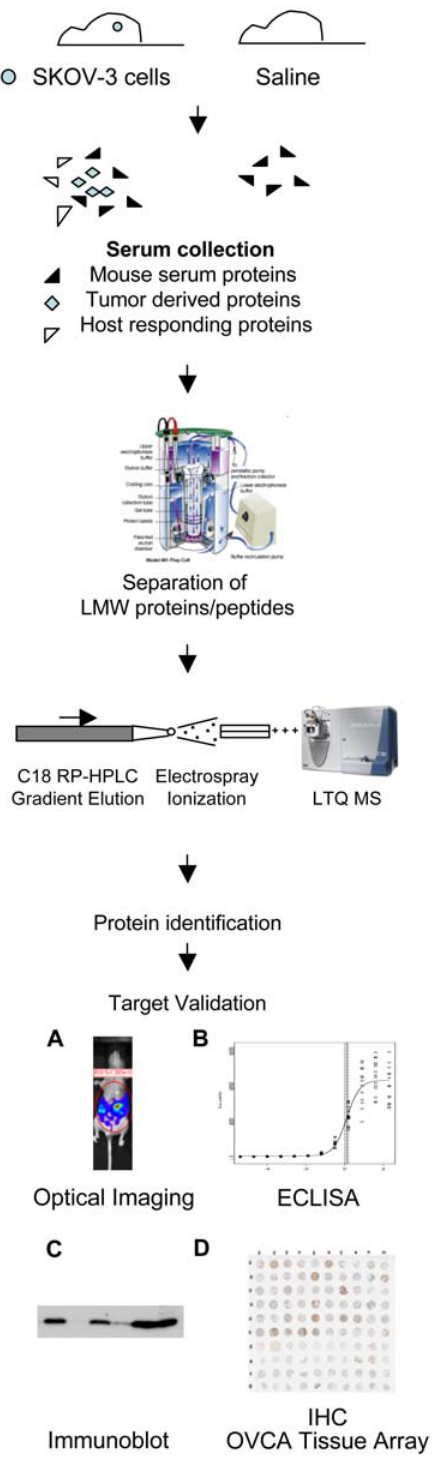
Figure 1. Experimental strategy to use MS discovery proteo- mics in low molecular weight (LMW) serum fraction from a mouse model of human ovarian cancer. To determine whether cancer-derived proteins have candidate biomarker potential, (A) a bioluminescent xenograft model, (B) ECLISA, (C) Western blot, and (D) OVCA tissue array immunohistochemistry (IHC) are utilized. This was followed up for S100A6 by analysis of human patient sera.